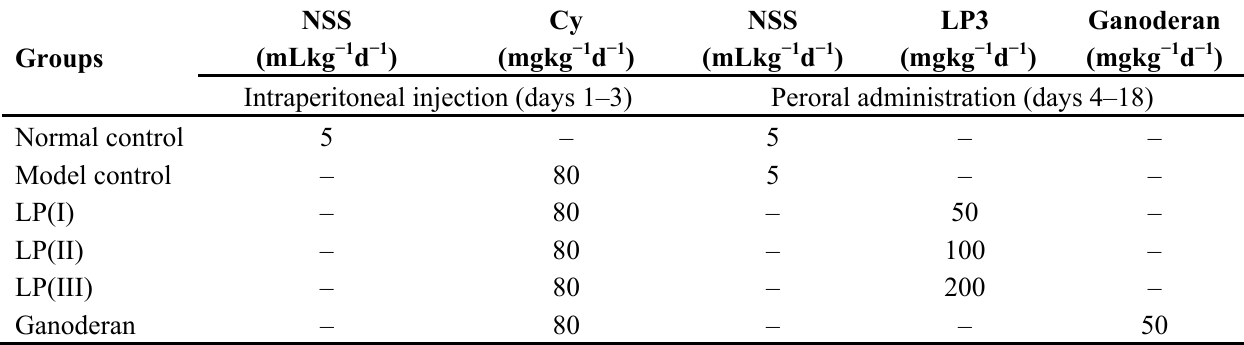
Table 1. Groups of mice with different treatments in vivo